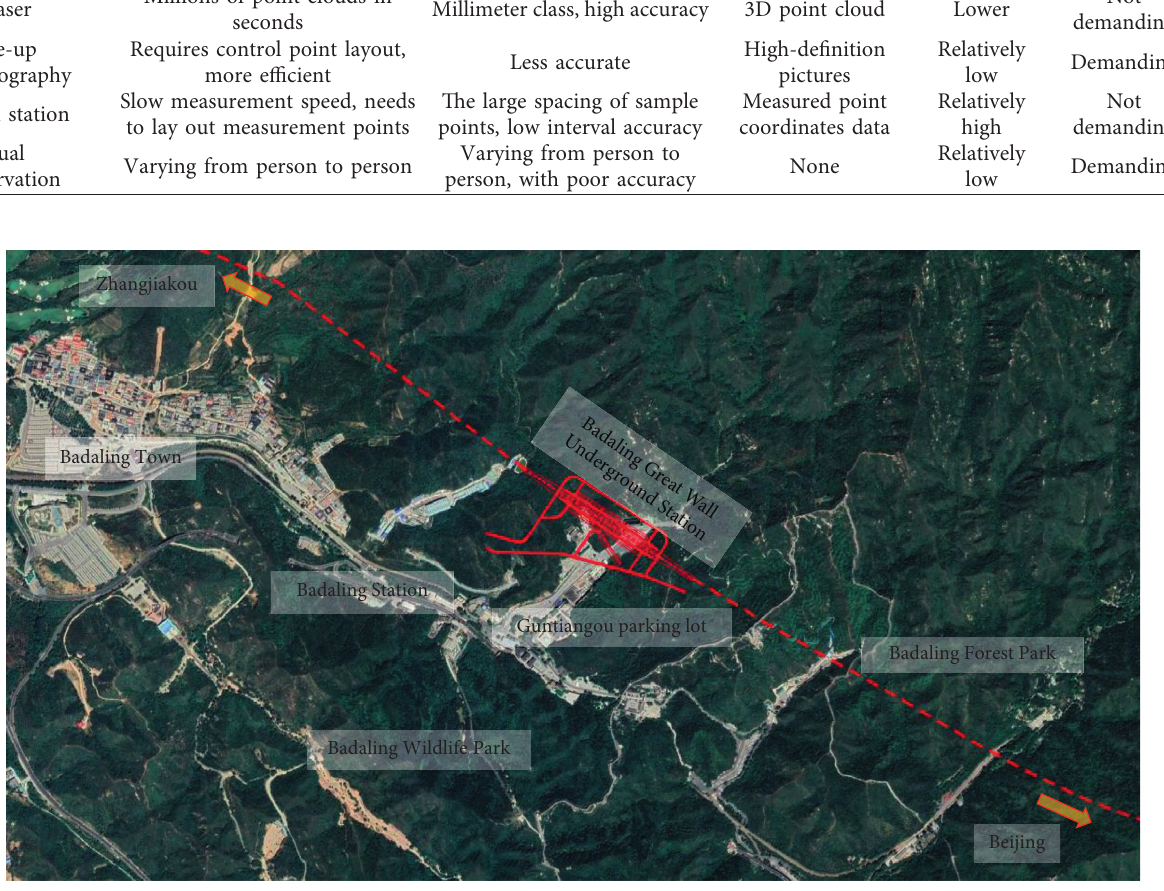
Figure 1: Location of Badaling Great Wall